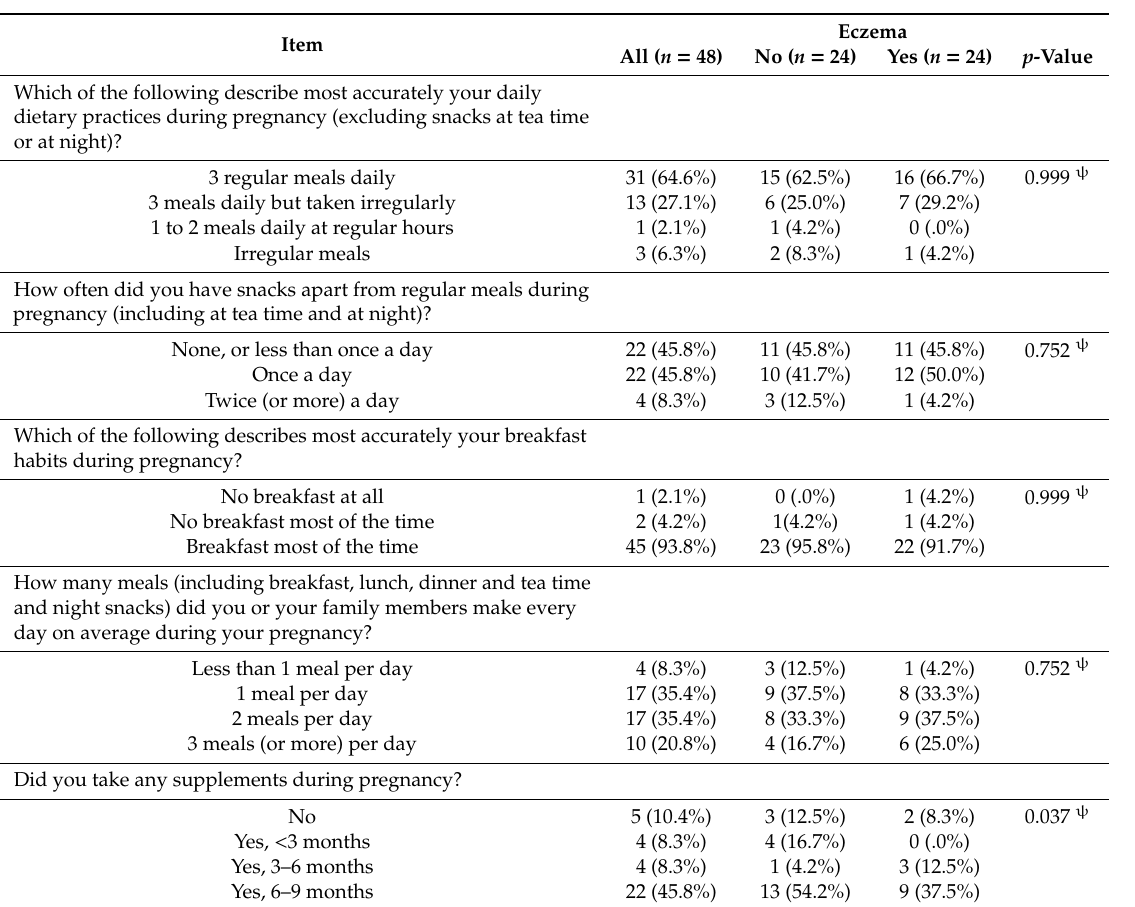
Table 4. Dietary practices in 48